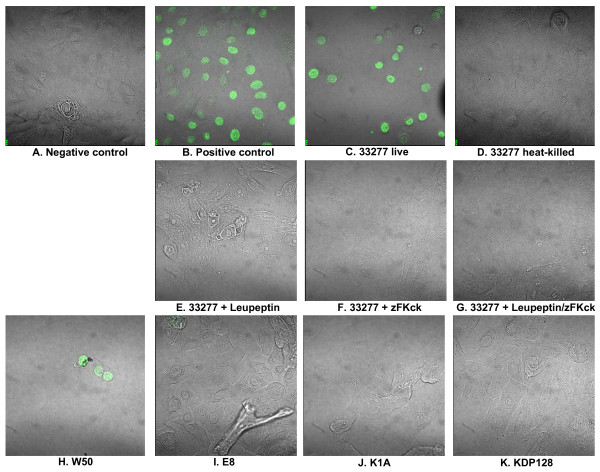
TUNEL assay to detect DNA fragmentation by confocal microscopy. Images are fluorescent confocal staining at ×600 magnification. Negative control was unchallenged HGECs (A). Positive control was HGECs treated with DNase 1000 U/ml (B). HGECs were challenged with live (C) and heat-killed (D) P. gingivalis 33277 MOI:100 for 24 h. Challenge with MOI:100 for 4 h and MOI:10 for 4 and 24 h gave no staining (data not shown). Additional plates (E to G) show challenge with live P. gingivalis 33277 at MOI:100 for 24 h that were pretreated with leupeptin, a selective Rgp inhibitor (E), zFKck, a selective Kgp inhibitor (F), or a cocktail of both inhibitors to inhibit total gingipain activity (G). Challenge with P. gingivalis W50 (H), the RgpA/RgpB mutant E8 (I), the Kgp mutant K1A (J) or the RgpA/RgpB/Kgp mutant KDP128 (K), at MOI:100 for 24 h are also shown.